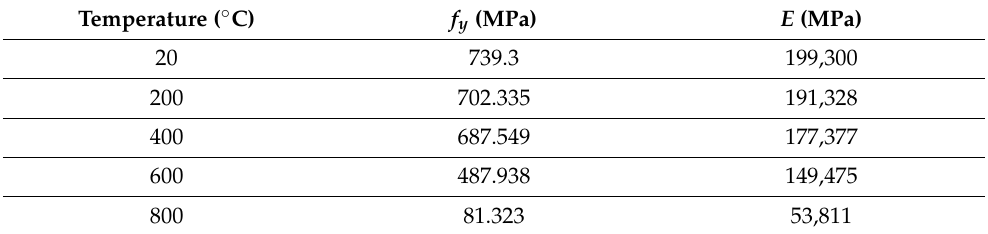
Table 2. Material properties of CFS S690QL steel grade [30].